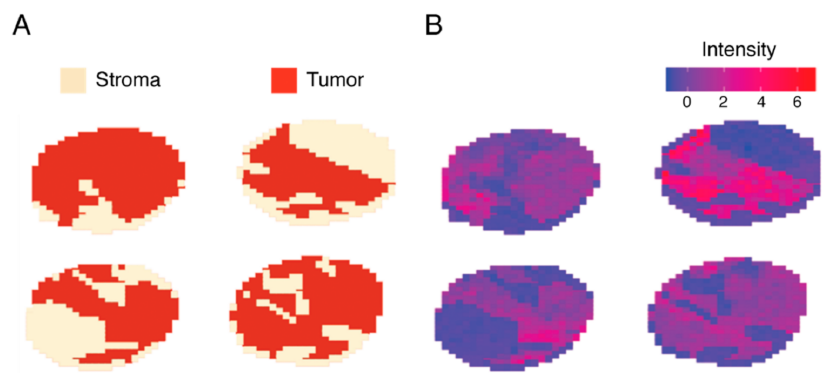
Figure 3. Juxtaposition of stroma labeling and feature intensity of 1106.719 m/z (histone H1.2). A subset of four stroma-labeled tumor cores depicted as ( A ) spatial distribution of expertly annotated stroma and malignant areas, and ( B ) a spatial distribution of intensities measured at 1106.719 m/z showing exclusive expression in malignant